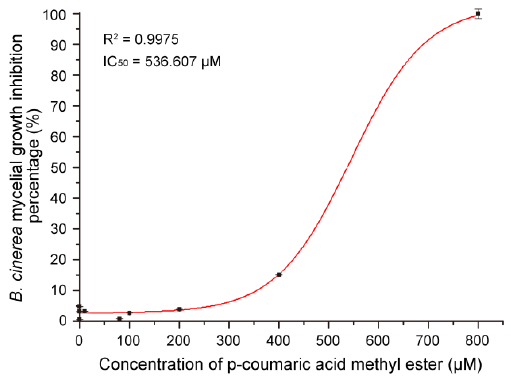
Figure 7. Effect of 13 compounds (A – M; Table 1; 1 mM) on the mycelial growth of B. cinerea . The same lowercase letters indicate that the difference was not significant at p < 0.05, according to Duncan’s multiple range tests.